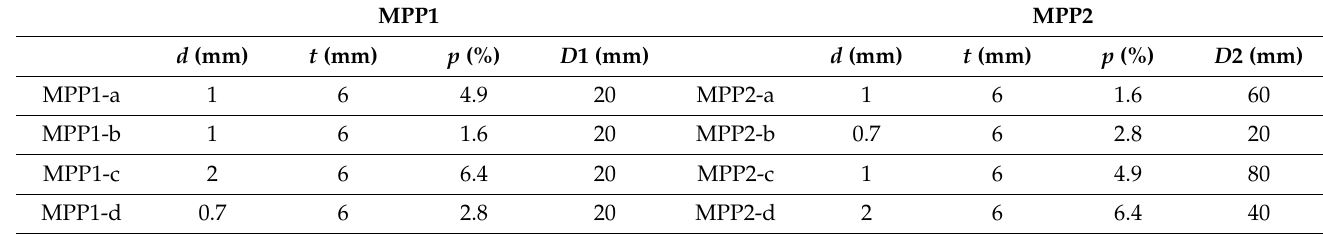
Table 2. Parameters of the two layers each having four parallel-arranged MPPs.